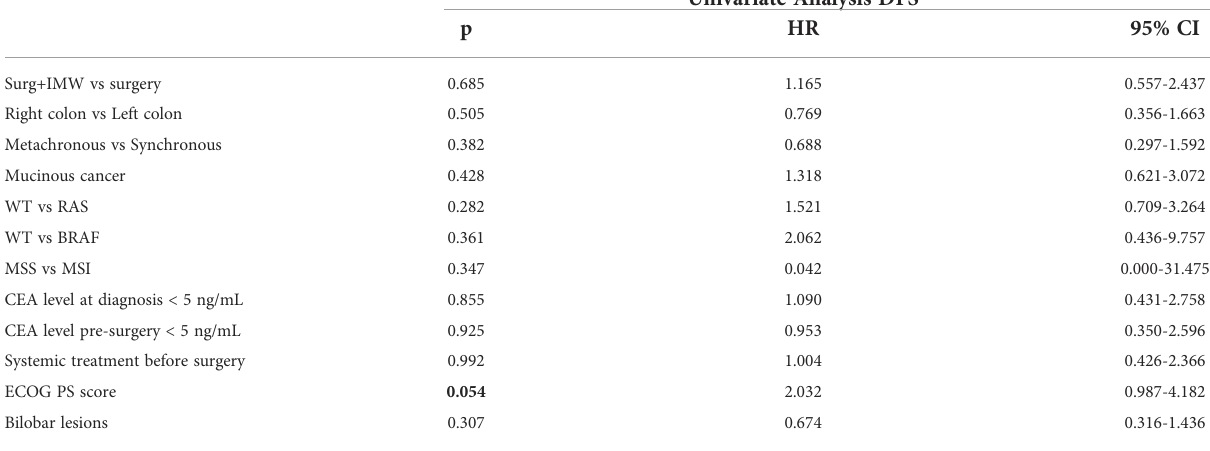
TABLE 4B Univariate and multivariate analysis for